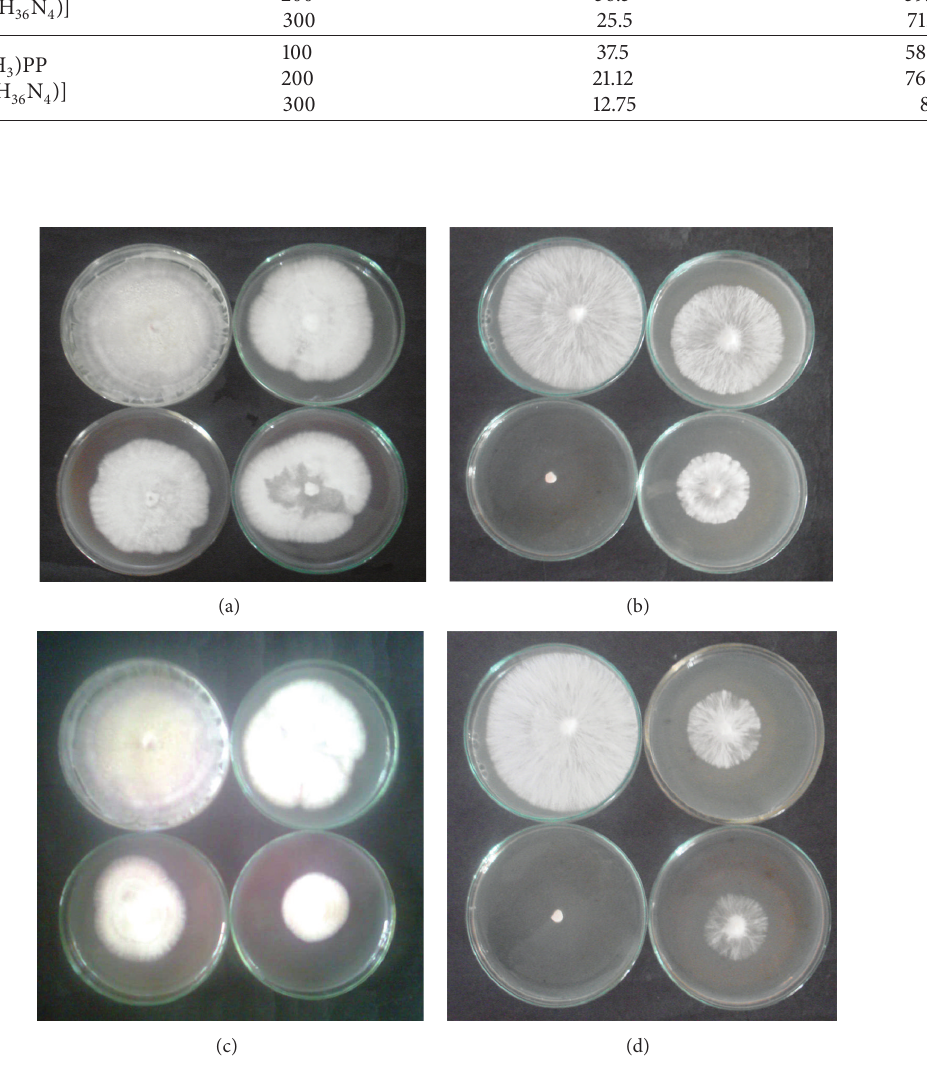
Figure6: (a)Antifungal activity of p -NH 2 phO-Zn-t( p -CH 3 )PP,(b)antifungal activity of p -OCH 3 phO-Zn-t( p -CH 3 )PP,(c) antifungal activity of p -NO 2 phO-Zn-t( p -CH 3 )PP, and (d) antifungal activity of p -ClphO-Zn-t( p -CH 3